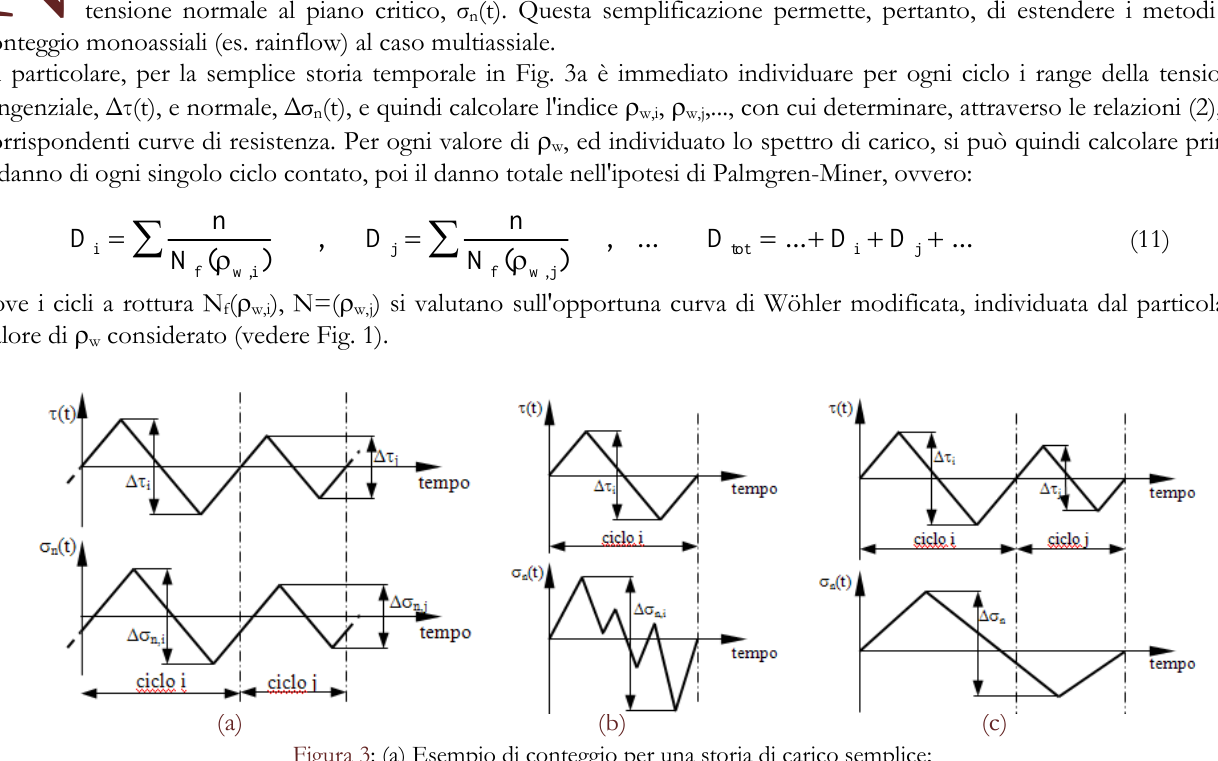
Figura 3: (a) Esempio di conteggio per una storia di carico semplice; (b), (c) esempi di conteggio per storie di carico più